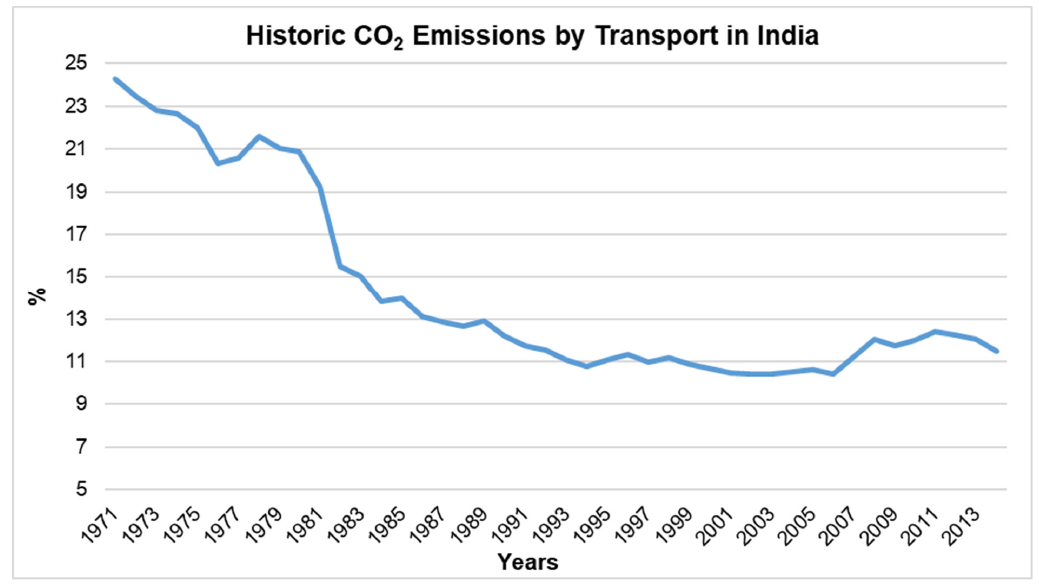
Figure 6. Historic CO 2 emissions for transportation in India.